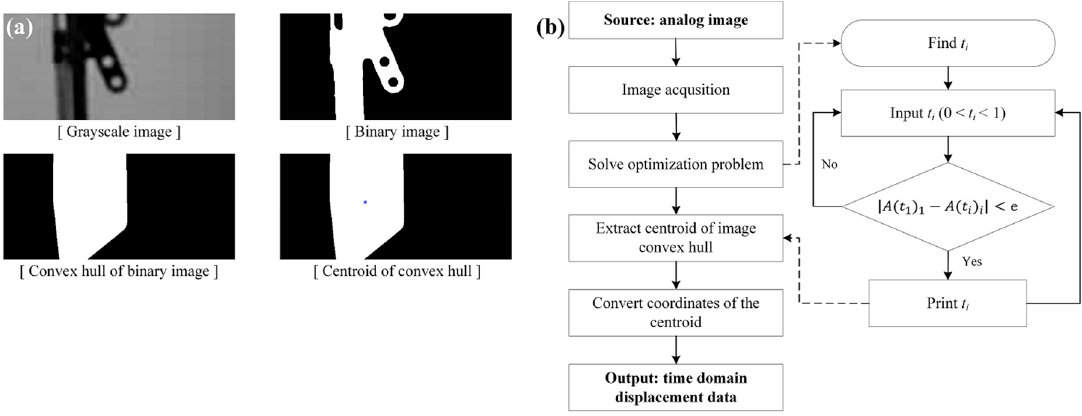
Figure 2. ( a ) Examples of the image convex hull; ( b ) Displacement extraction algorithm of the proposed TVDS.